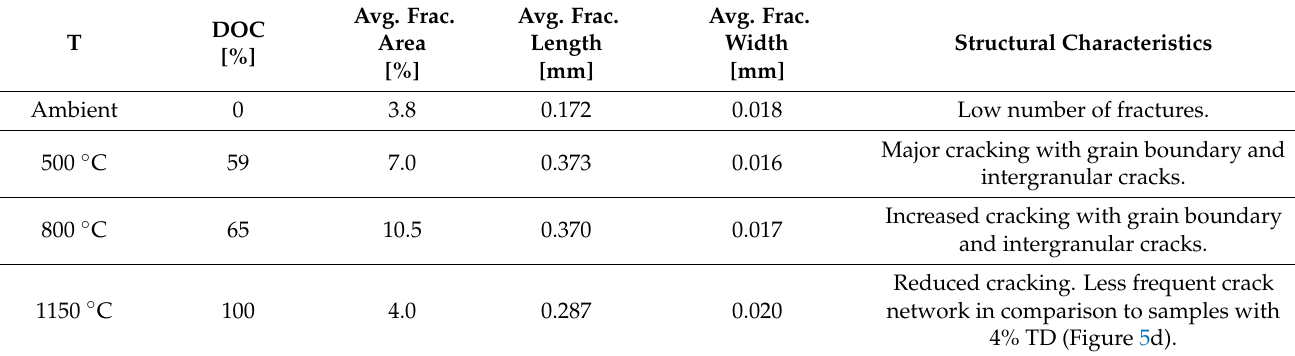
Table 5. Summary of image analysis results of fractures for sample 71 (TD = 75%) based on three samples in each temperature group. T = temperature, DOC = degree of calcination, Avg. frac. Area = average fractured area, Avg. frac. Length = average length of fractures, Avg. frac. Width = average width of